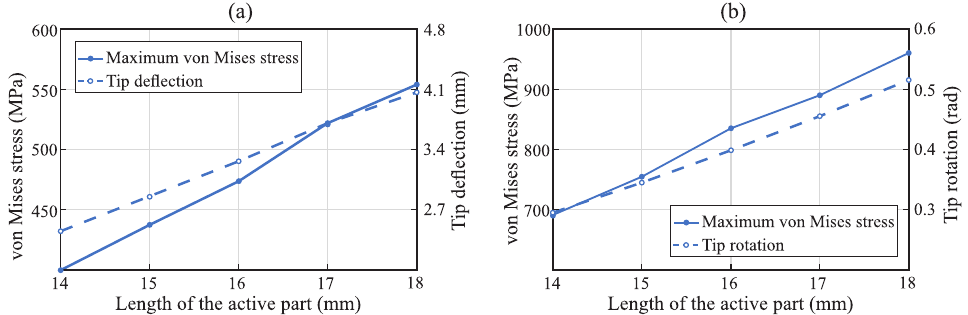
Figure 12. Results of the parametric study of the length of the active part: ( a ) bending analysis and ( b ) torsional